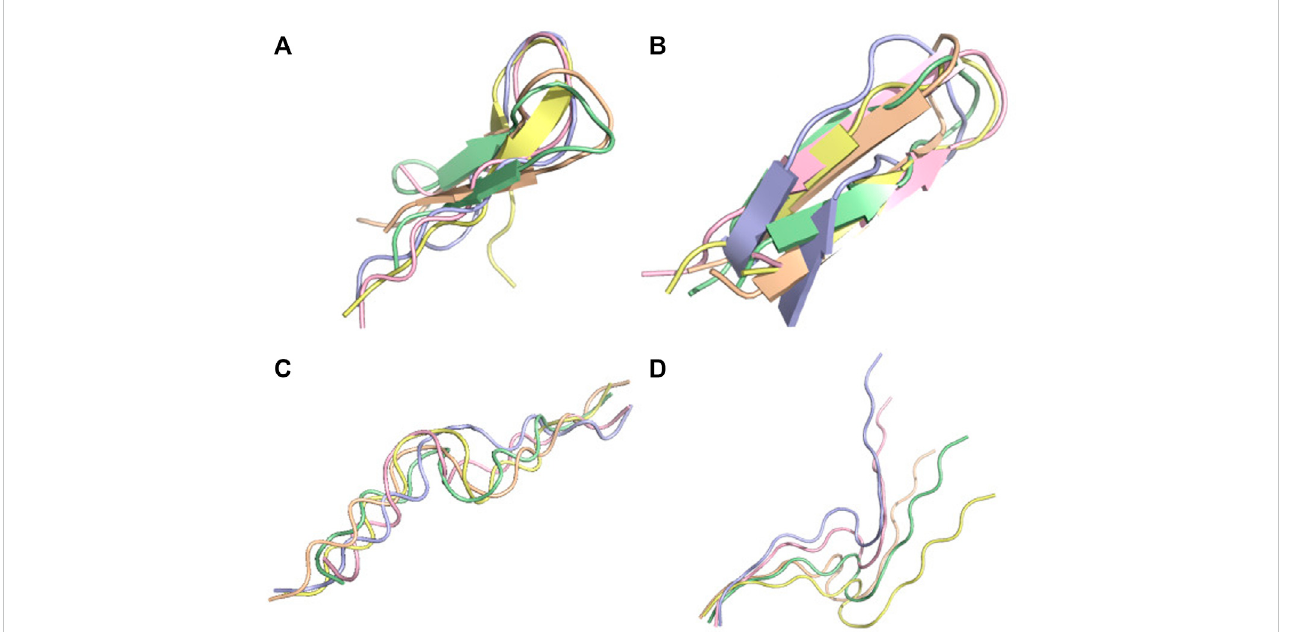
FIGURE 9 Conformation ensemble of tau-fragment at pH 7. (A) PF-noDH, (B) PF-DH, (C) AlphaFold2 and (D) TrRosetta. For each method, the 5 predicted models are